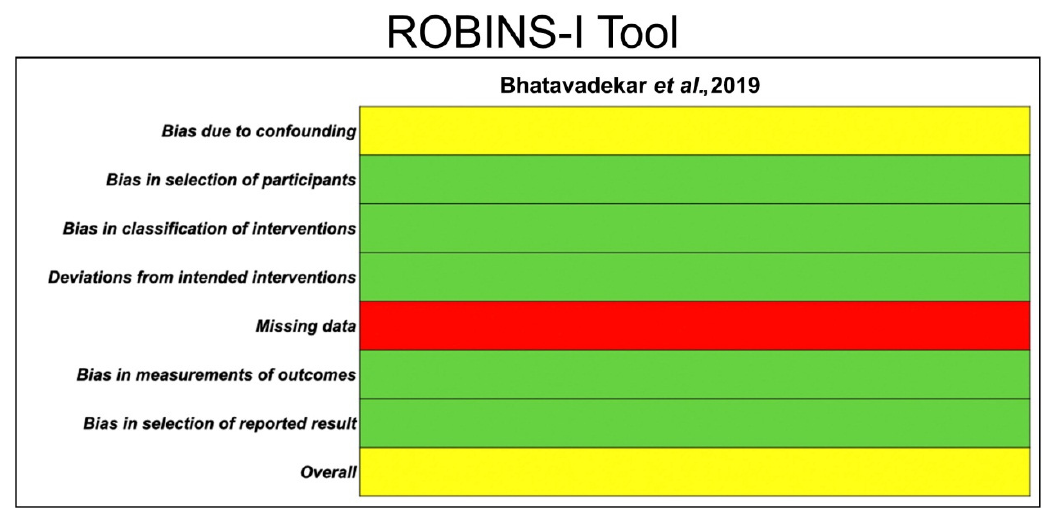
Figure 4. Quality evaluation of the CCT using the ROBINS-I tool. The risk of bias in the included study was classified as low (green), moderate (yellow) or serious (red).